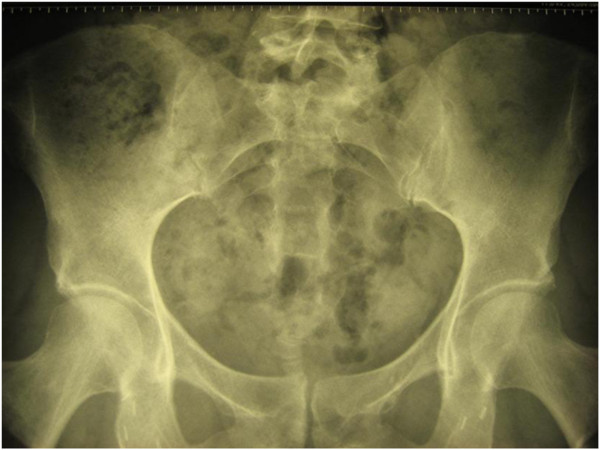
Right-sided sacroiliitis persisting 1 month after diagnosis.